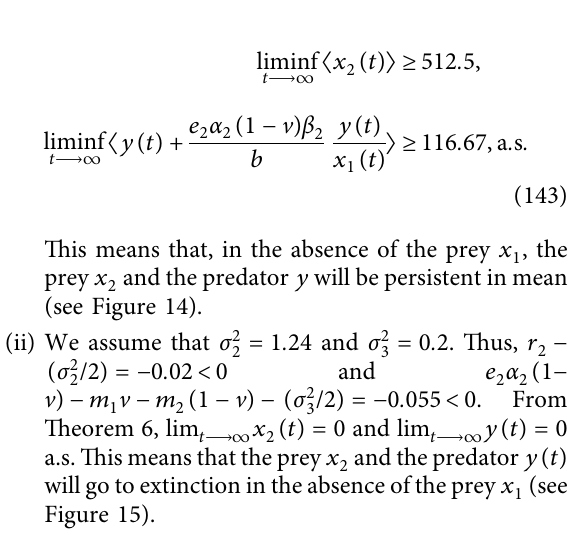
� 0 . 02 (color figure 3